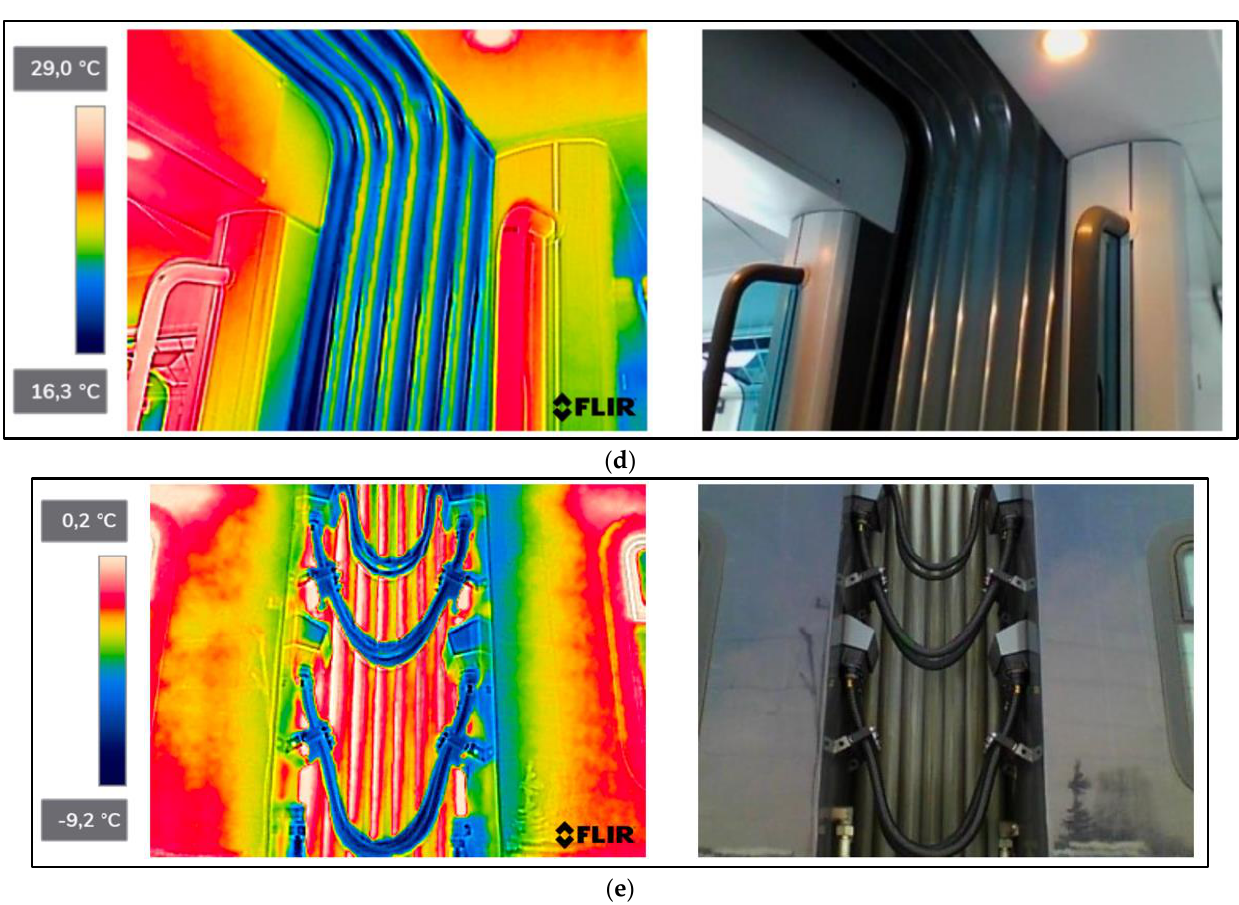
Figure 3. 22WEd-011 − thermogram of critical components of the railway vehicle: ( a ) door − upper part from inside the vehicle; ( b ) door − lower part from inside the vehicle; ( c ) door from outside the vehicle; ( d ) interconnection from inside the vehicle; ( e ) interconnection from outside the vehicle.